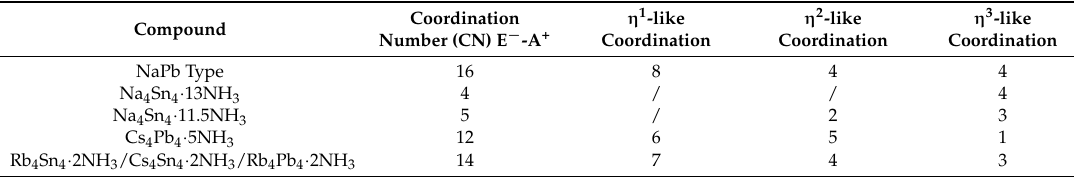
Table 4. Coordination number of the [E 4 ] 4 − cages in NaPb and related